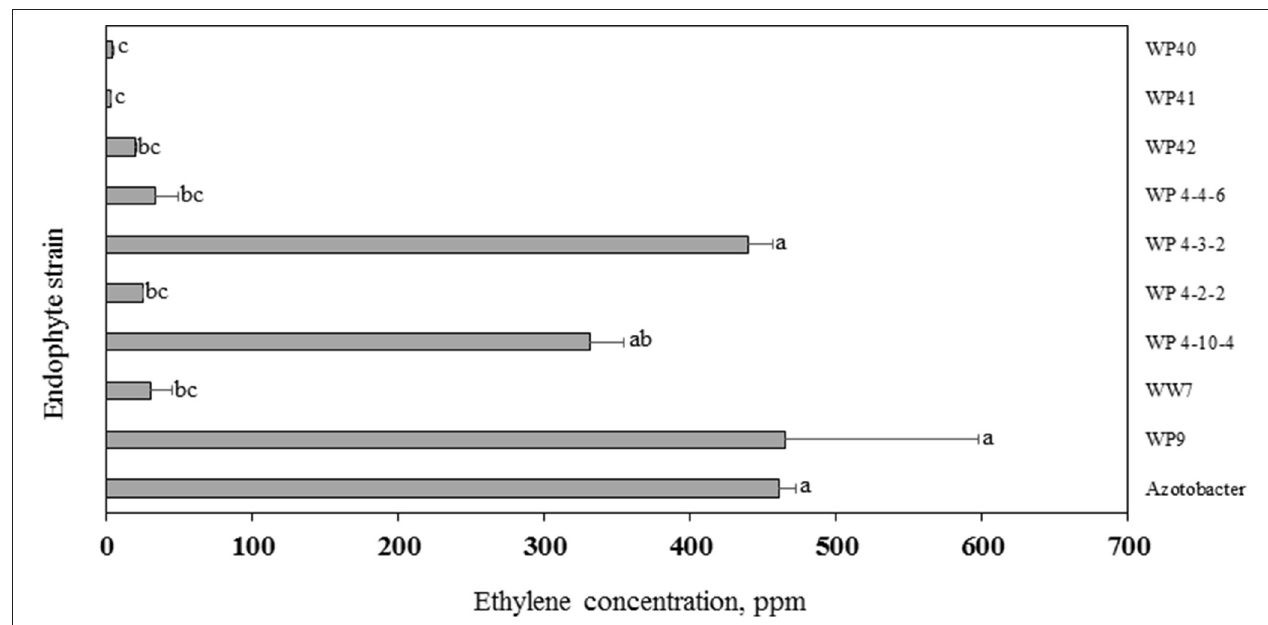
FIGURE 8 | Acetylene reduction assay. Ethylene produced by endophyte strains after 24 h of exposure to acetylene. Histograms that do not share a letter are significantly different at < 0.05 probability